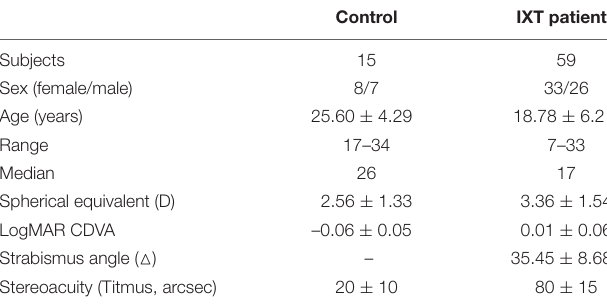
TABLE 1 | Demographics of the control and IXT patients in the study.